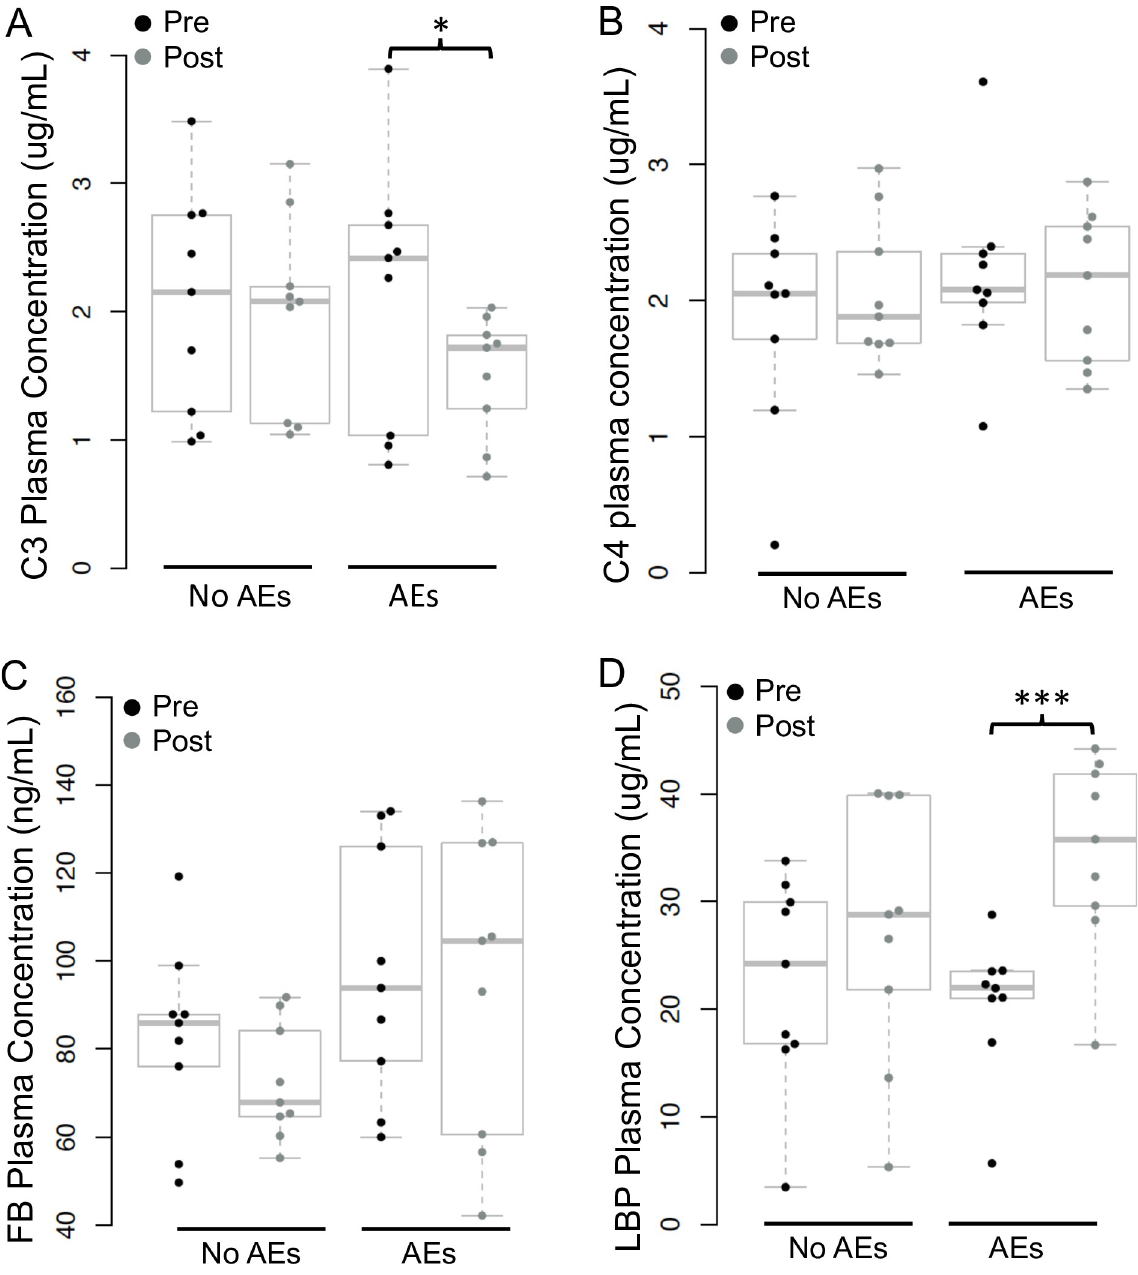
Fig 2. Levels of complement components and lipopolysaccharide binding protein (LBP) pre- and post-treatment (n = 9 with moderate adverse events (AEs), n = 9 with no AEs). Fig 2A: Complement component 3 (C3) significantly decreased post-treatment in individuals with moderate AEs ( � P = 0.03 by paired t-test). B: Complement component 4 (C4) did not change with treatment in either AE group. C: Complement Factor B (FB) did not change with treatment in either AE group. D: LBP levels significantly increased post-treatment in individuals with moderate AEs ( ��� P = 0.00007 by paired